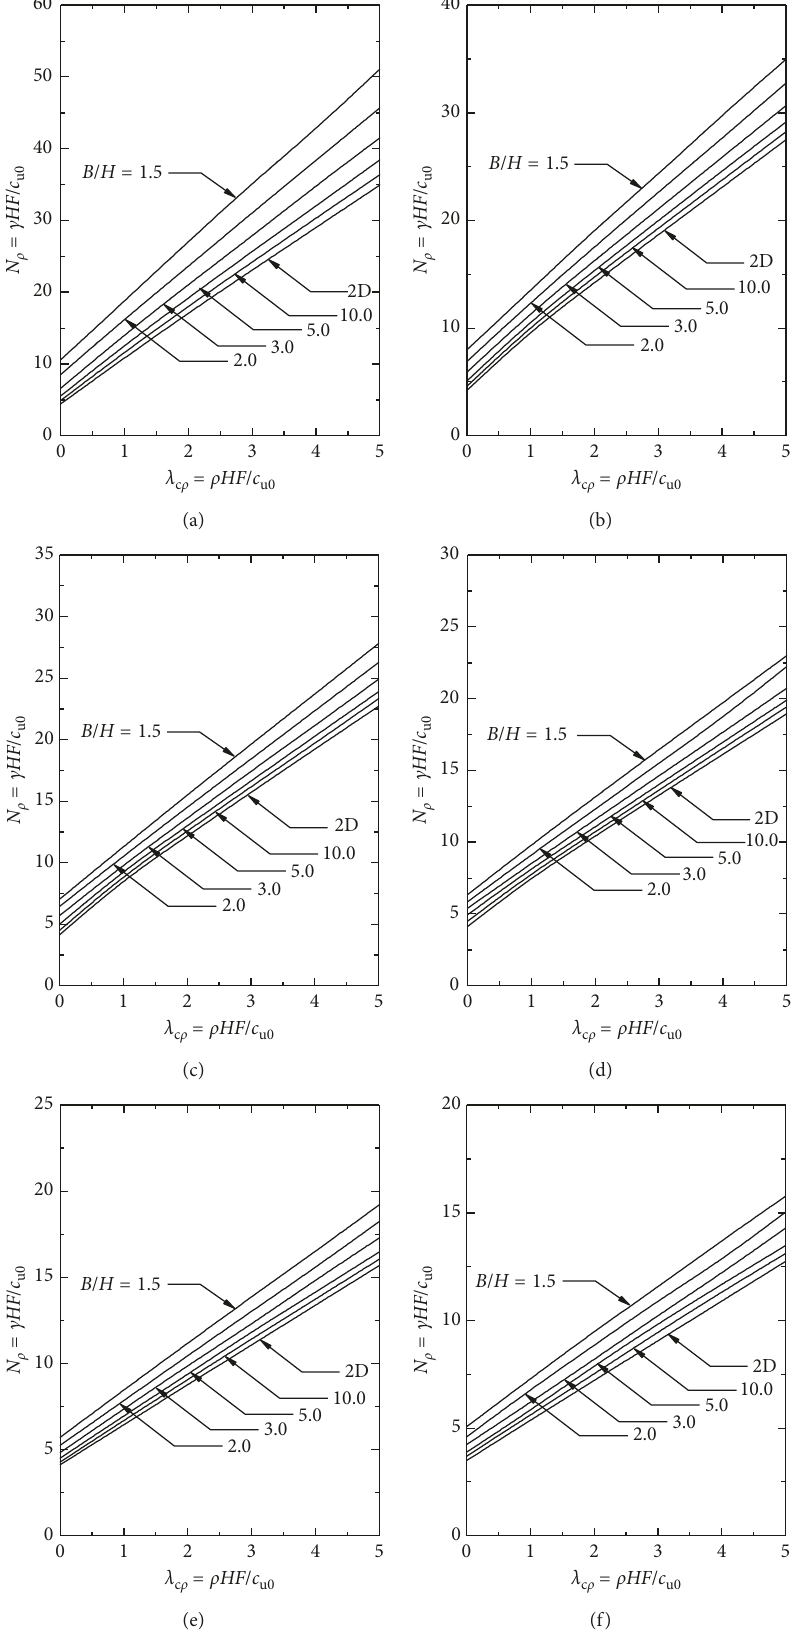
Figure 7: Seismic stability charts for cut slopes with k